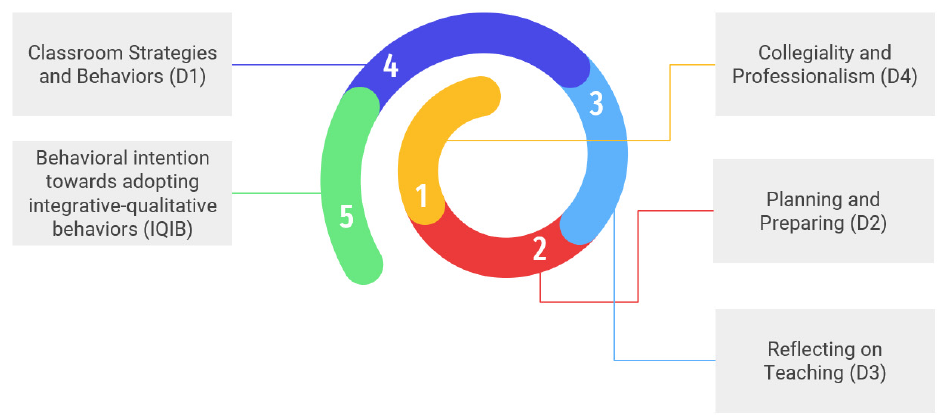
Figure 2. The complementary sequential mediation pathway for enhancing behavioral intention toward adopting integrative–qualitative behaviors (IQIB).